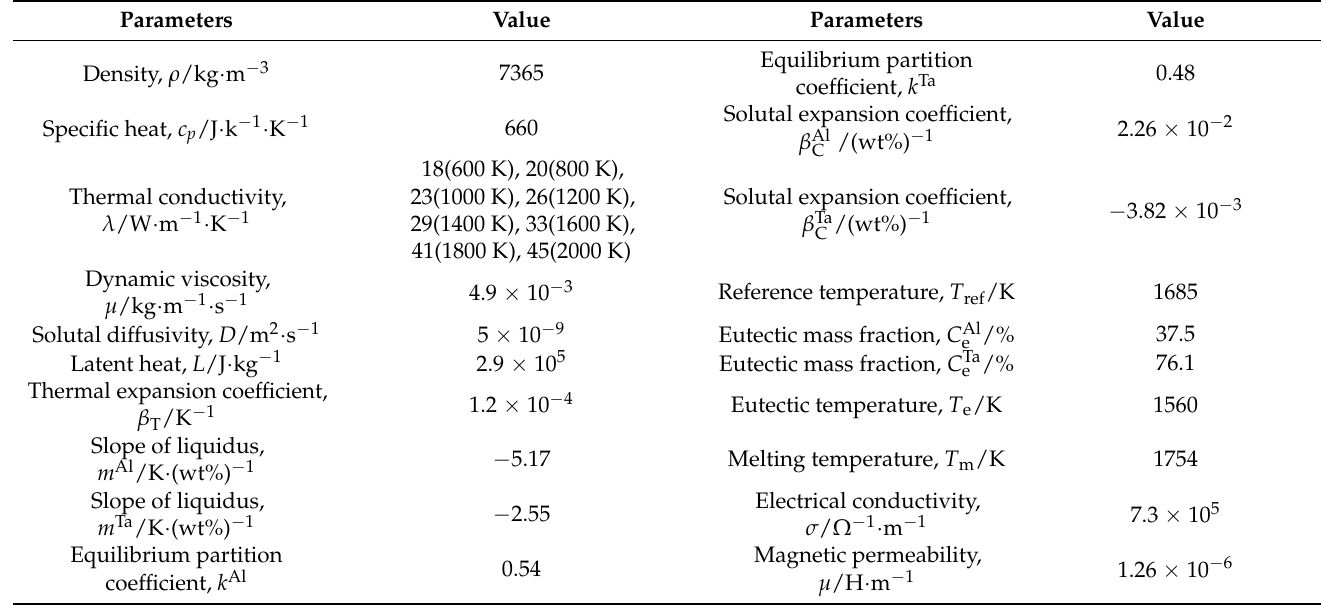
Table 2. Thermophysical properties of Ni-5.8 wt% Al-15.2 wt% Ta alloy used for